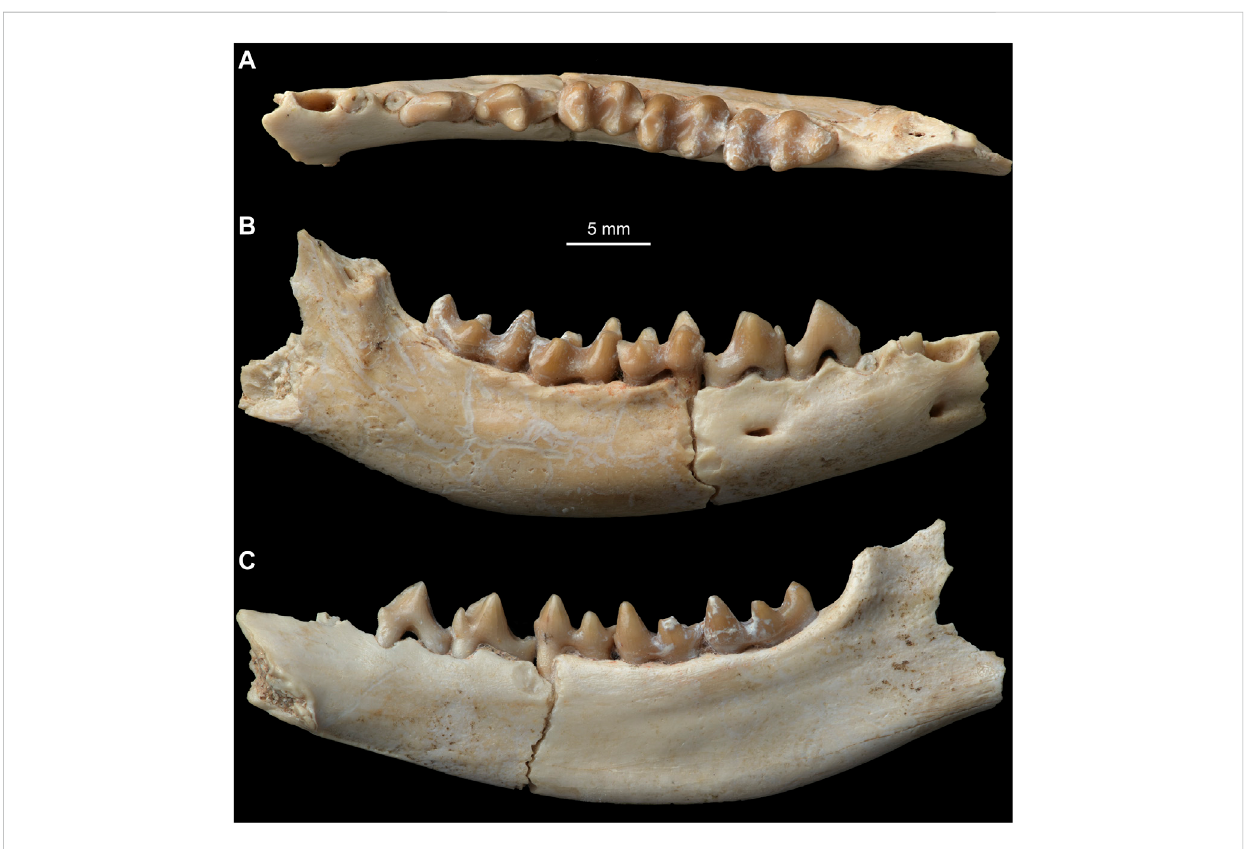
Rightlowerjawof Obotherium tongi gen.etsp.nov.withp3-m3 andalveoli ofcanine,p1, androotofp2(IVPPV 31731). (A) occlusal view; (B) buccal view; (C) lingual